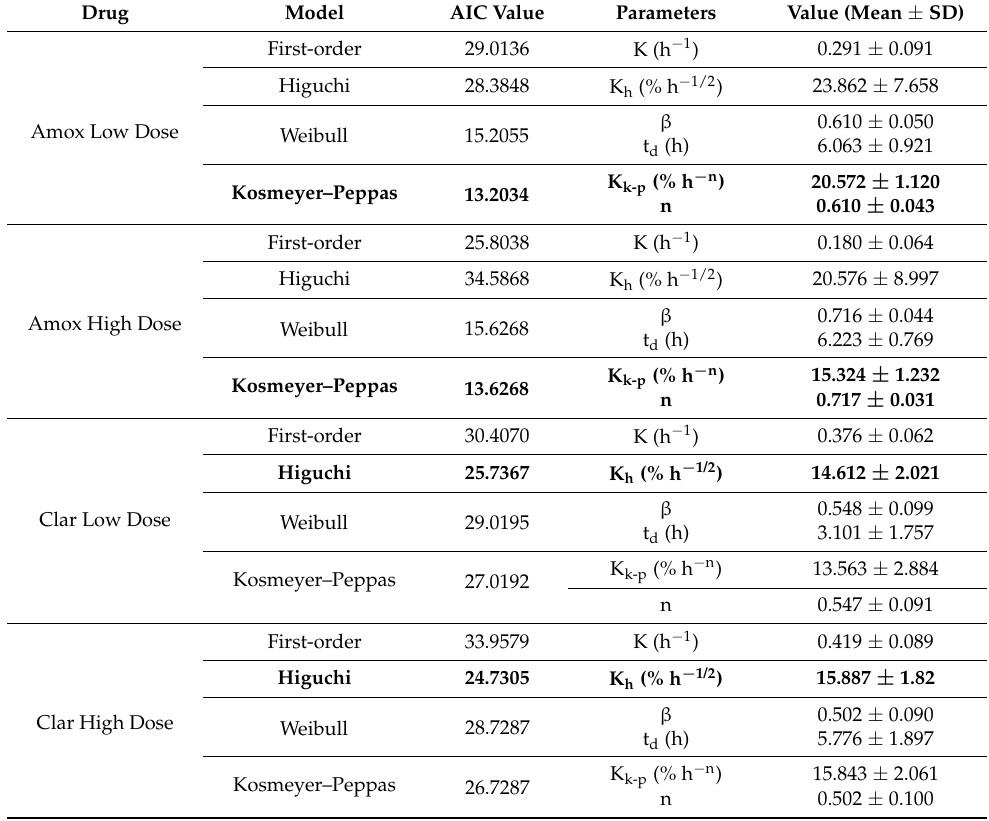
Table 4. Model fit and release parameters of Amox and Clar (high and low doses). AIC: Akaike Information Criterion. Bold indicates the model selected based on the lowest AIC. β is a dimen- sionless parameter. High dose: 89.4 mg/kg/day of Amox and 44.7 mg/kg/day of Clar. Low dose: 8.94 mg/kg/day of Amox and 4.47 mg/kg/day of